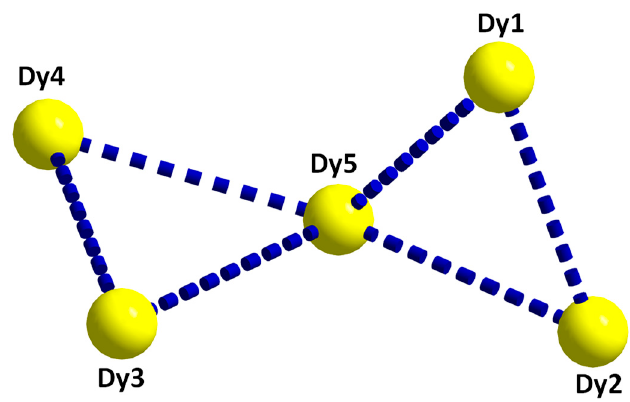
Figure 2. ( Top ) The complete [Dy 5 ( µ 3 -OH) 2 ( µ -OR) 8 ] 5+ core of 1 , and ( bottom ) its {Dy 5 } bowtie-like topology. The blue dashed lines are virtual bonds to show the two vertex-sharing triangles. Color scheme as in Figure 1.